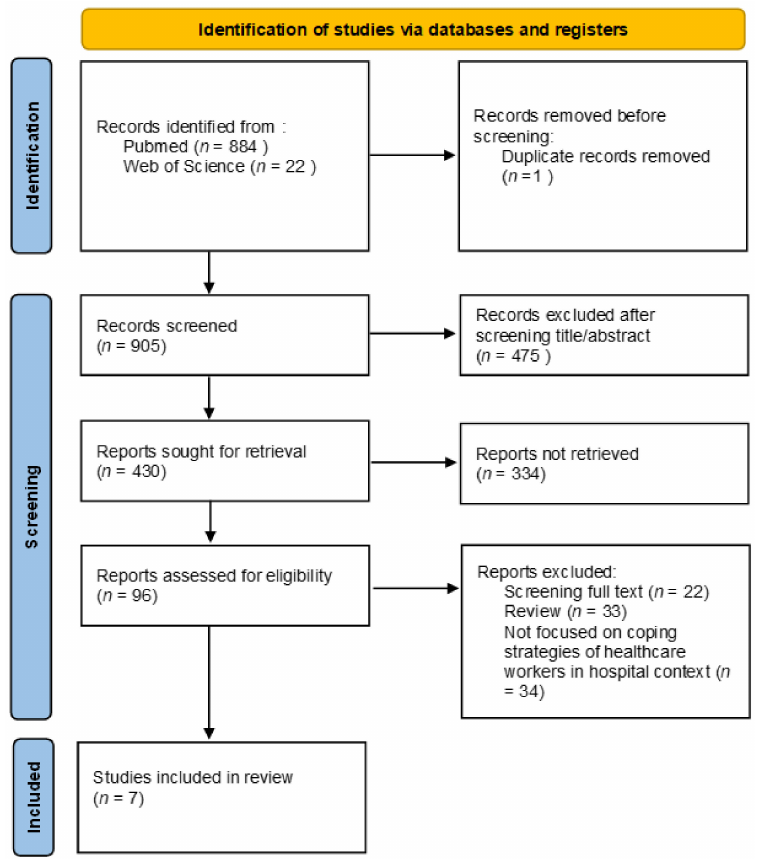
Figure 1. PRISMA 2020 flow diagram of evaluated